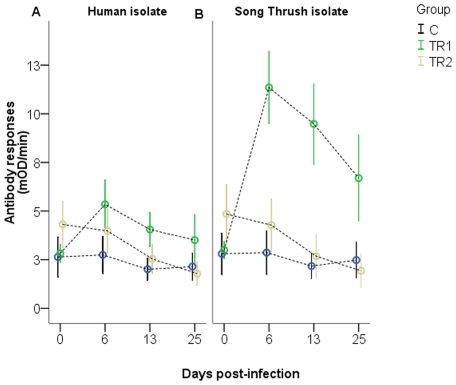
Development of antibody responses over the course of the infection experiment.For each treatment group and sampling occasion, the mean (with 95% confidence interval) of the birds' antibody responses (mOD/min) to membrane proteins of the (A) human C. jejuni isolate 00F4382 and (B) the Song Thrush isolate 00-4:268 are given. The control birds are shown in blue, TR1 birds in green, and TR2 birds in yellow. Samples were taken at days 0, 6, 13, and 25 post-infection.